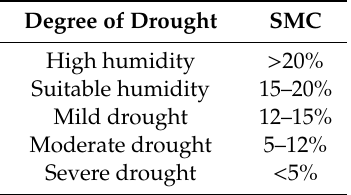
Table 3. Grading table of soil drought